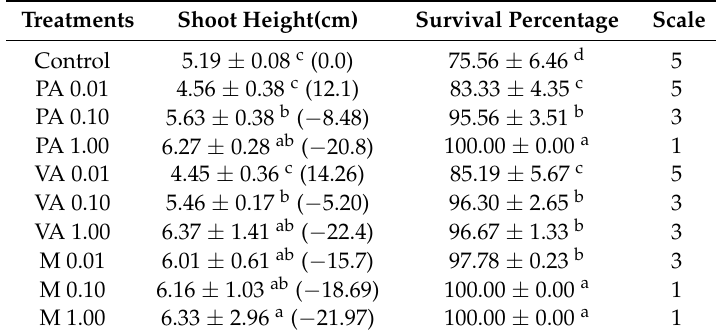
Table 1. Effects of exogenous application of phenolic acids on shoot height of rice in